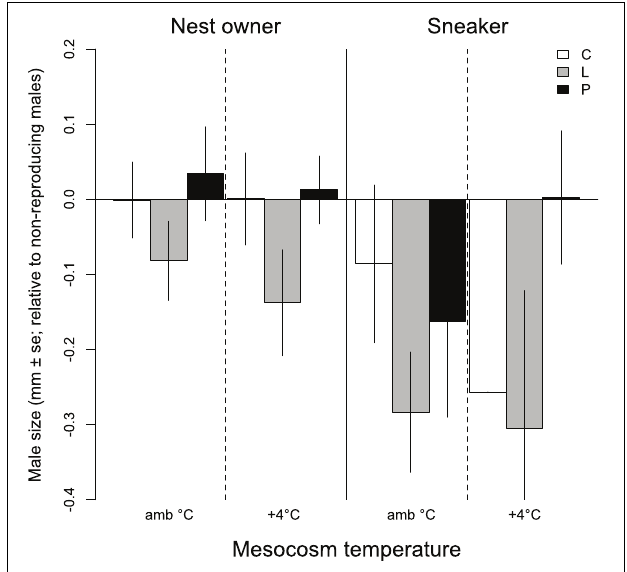
FIGURE 2 | Size of male nest owners and sneakers (mm ± SE) relative to non-reproducing males for each plate morph (C, complete; L, low; P, partial) in ambient and +4 ◦ C mesocosms.